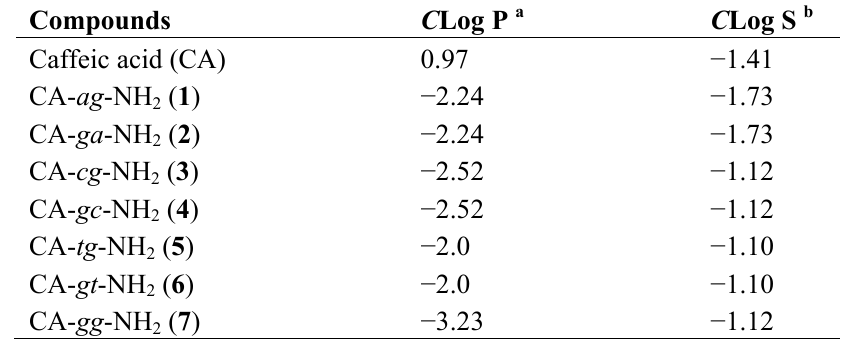
Table 2. Partition coefficient ( C Log P) and aqueous solubility ( C log S) of CA-PNA